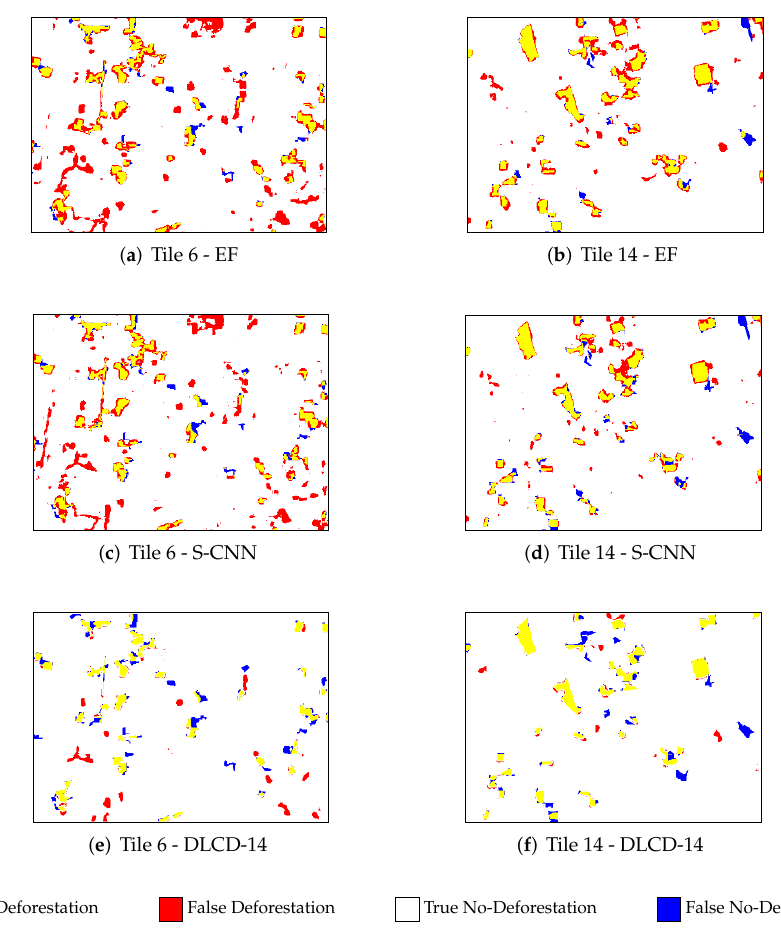
Figure 6. Change maps predicted by EF, S-CNN, and DLCD-14 on test tiles 6 and 14 for